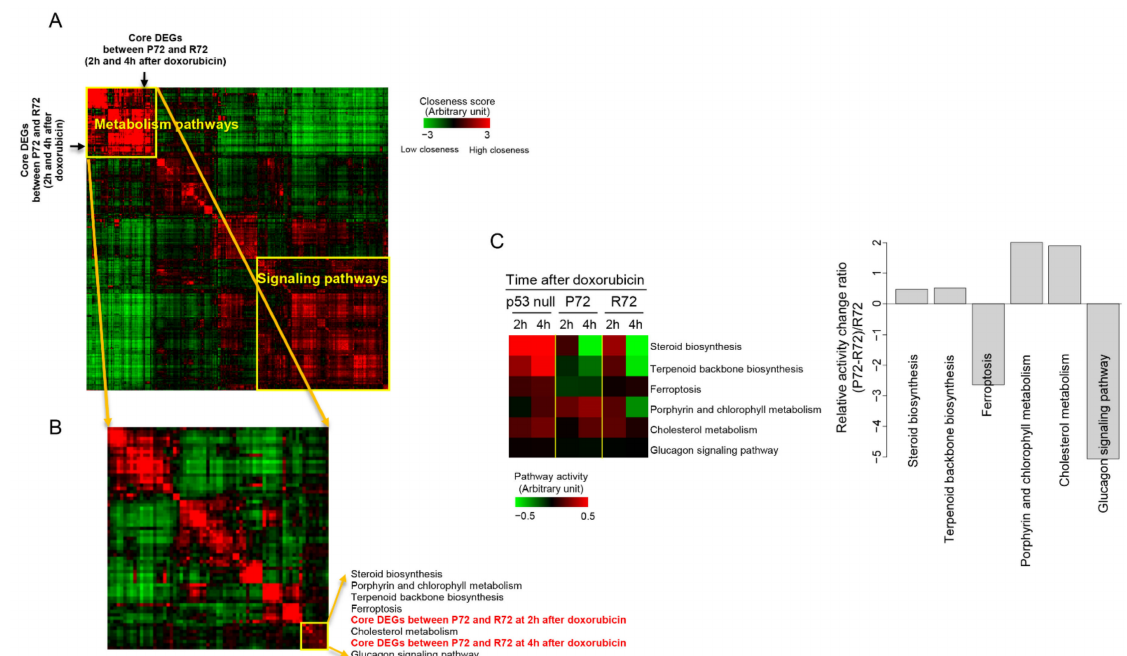
Figure 5. Measurement of the distance in the network. ( A ) Pathways were clustered according to distance distribution patterns of genes included in the pathways in the network. The location of core DEGs that were differentially expressed between P72 and R72 cells is indicated. ( B ) One cluster composed mainly of metabolic pathways and core DEGs between P72 and R72 cells was isolated and re-clustered. A cluster containing the core DEGs between P72 and R72 cells was finally isolated, and the pathways comprising this cluster are shown. ( C ) In the left panel, the activity levels for these finally isolated pathways are color-coded. Red and green indicate high and low activity levels, respectively, as indicated by the scale bar. In the right panel, the relative ratio of pathway activity changes between p72 and R72 was measured for these selected pathways. The relative ratio of pathway activity was determined as